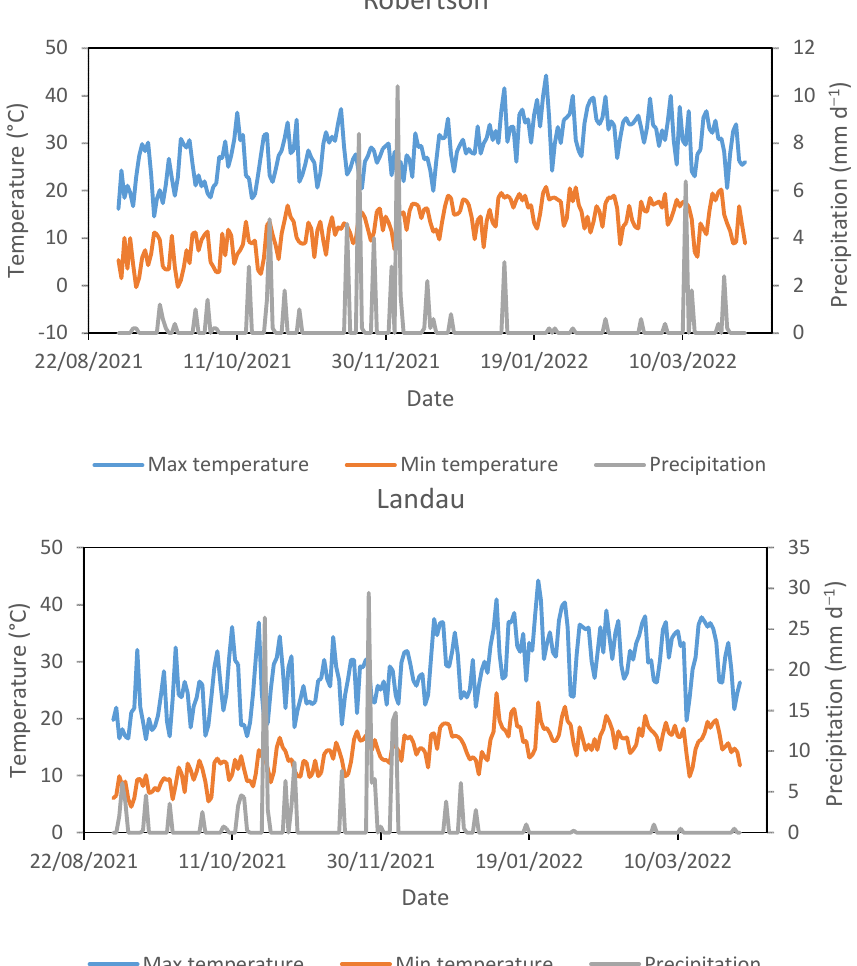
Figure 2. Weather data for Robertson ( top ) and Landau, Wellington ( bottom ) during the period of study from September 2021 to March 2022.